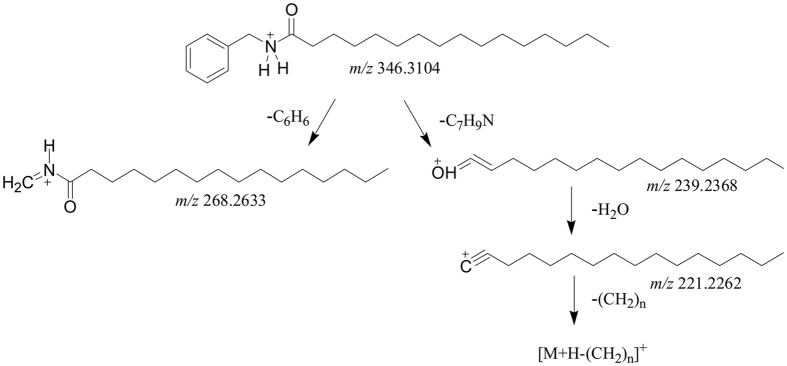
The fragmentation patterns of N-benzylhexadecanamide (No. A54).